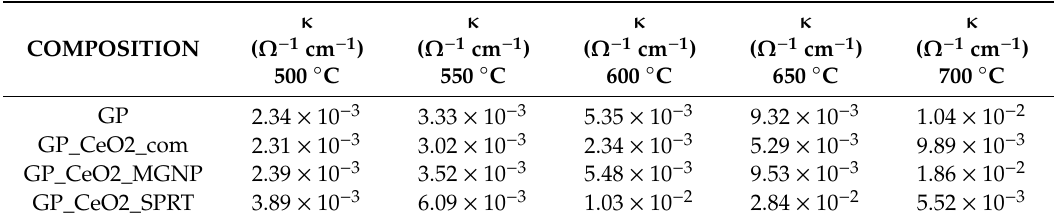
Table 1. The temperature dependence of total electrical conductivity ( κ ) of the pure GP, GP_CeO 2 _com, GP_CeO 2 _MGNP, and GP_CeO 2